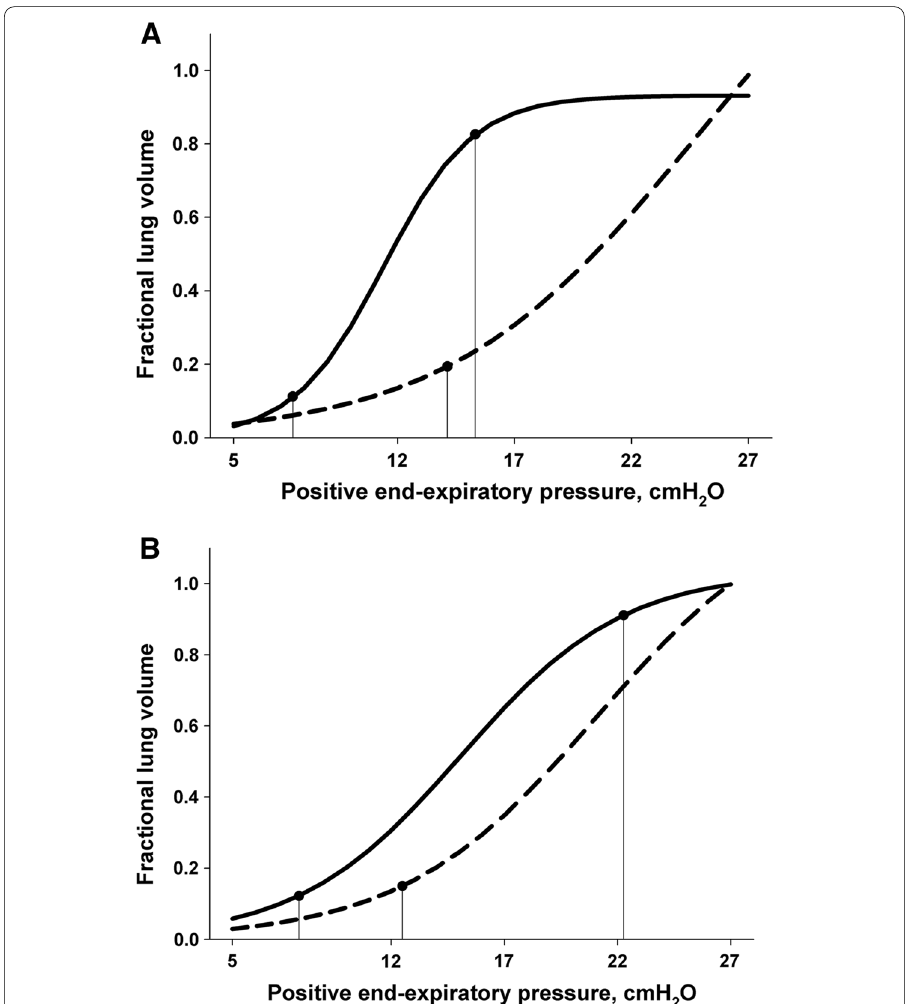
Fig. 2 End‑expiratory pressure–volume curves for atelectatic (solid line) and overdistended lung volume (dashed line) are depicted for healthy ( a ) and injured lungs ( b ). Fractional lung volumes are given as the difference between 5 and 27 cmH 2 O of positive end‑expiratory pressure (PEEP). Median pressure–volume curves were derived, and lower and upper inflection points were calculated using the Venegas equation [30]. For atelectatic lung, lower and upper inflection points and for overdistended lung, lower inflection points are